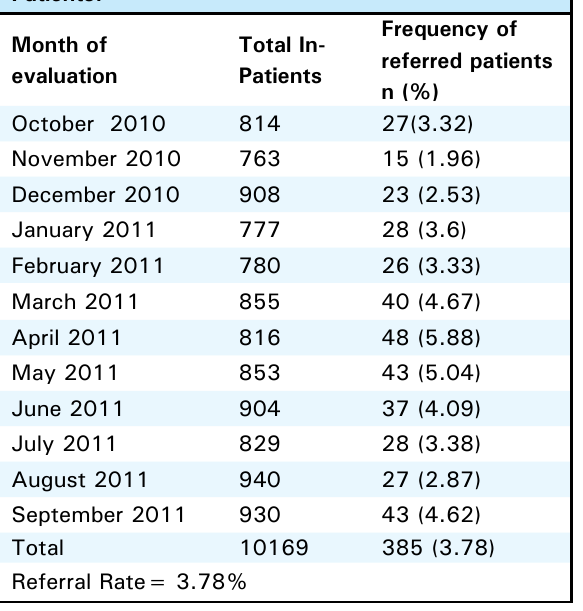
Table 2. Month wise Presentation of referred Patients.